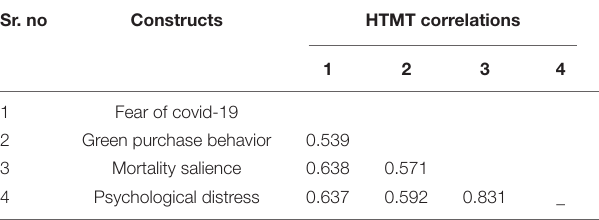
TABLE 4 | Discriminant validity—Fornell–Larcker criterion. Constructs